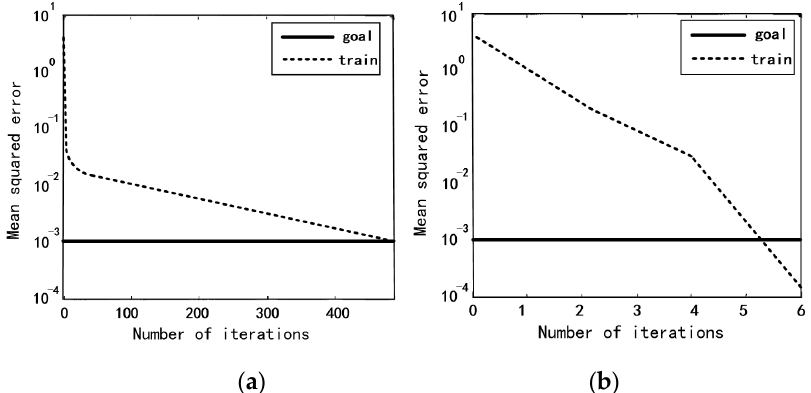
Figure 7. Comparison of network training curves. ( a ) Original BP neural network training curve; ( b ) LM algorithm-improved BP training curve.